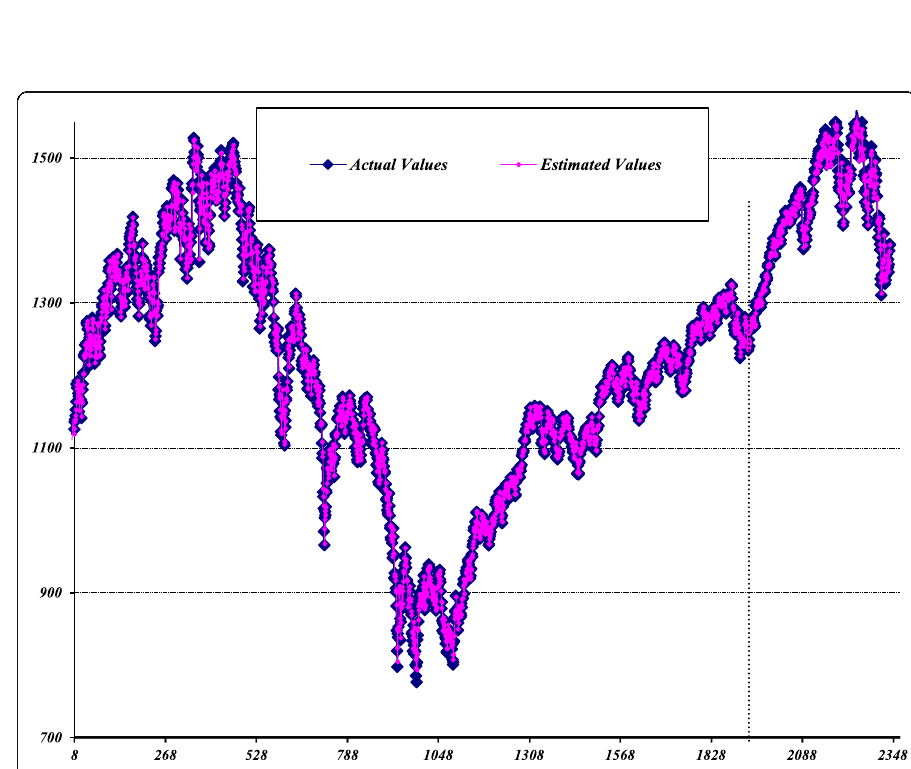
Fig. 12 Estimated values of MLP-ARIMA model for S&P500